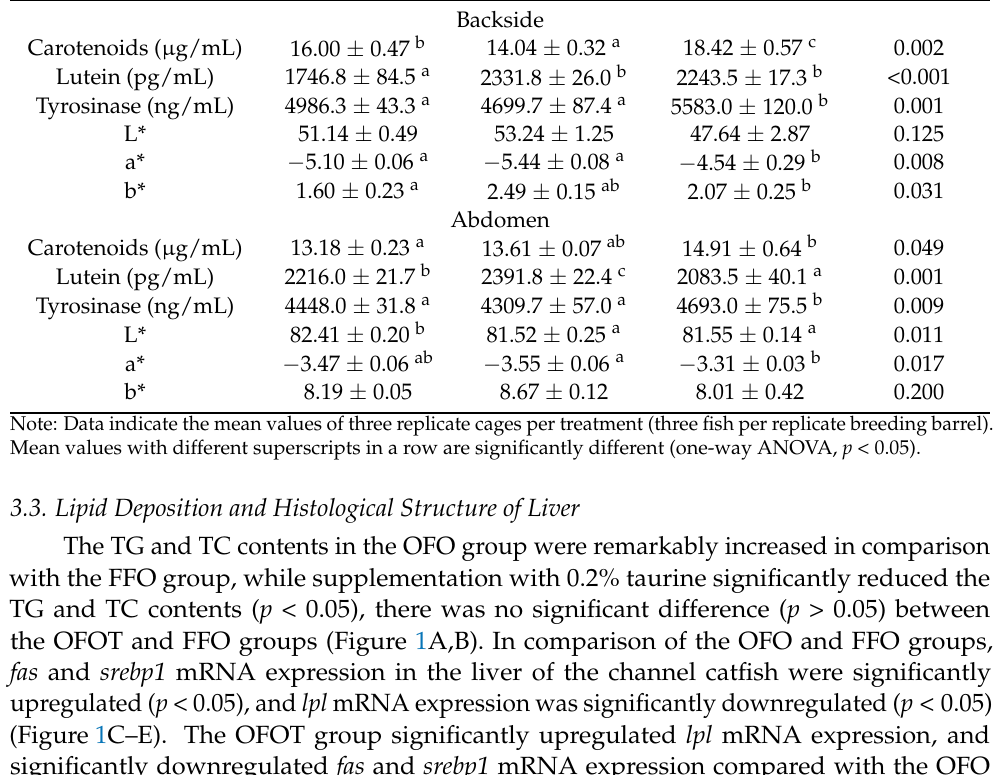
Effects of dietary taurine on skin pigment and body color of channel catfish ( Ictalurus punctatus ) fed oxidized-fish-oil diets. FFO OFO OFOT p -Value Backside Carotenoids ( µ